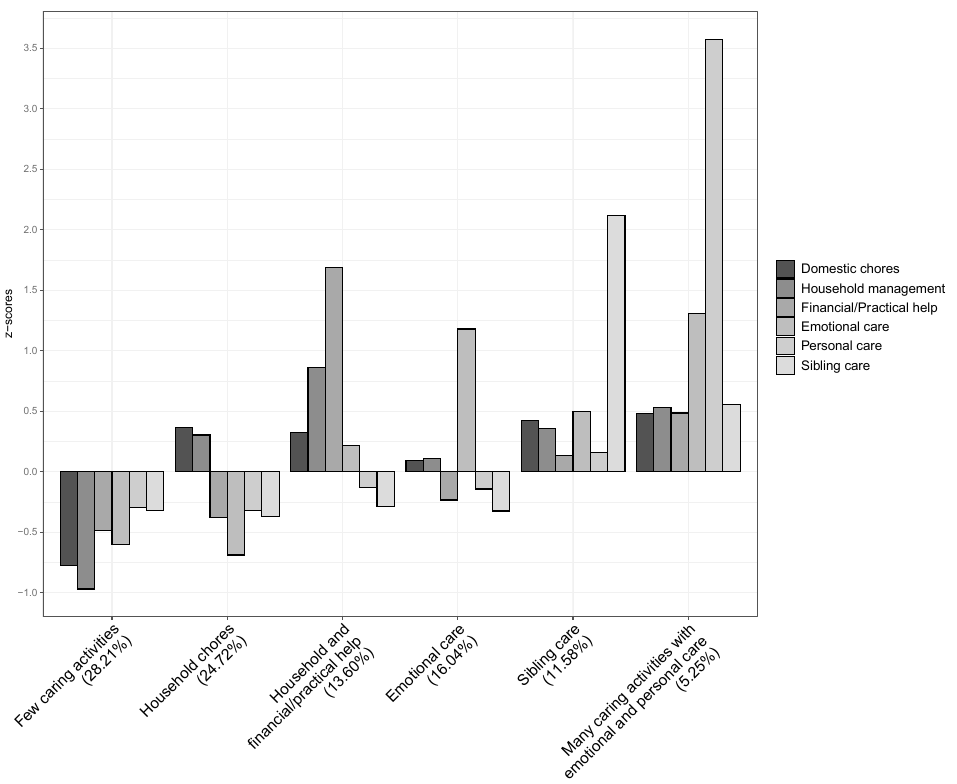
Figure 2. Cluster solution for caring activities. N = 3273. z-scores for domestic chores, household management, financial/practical help, emotional care, personal care, and sibling